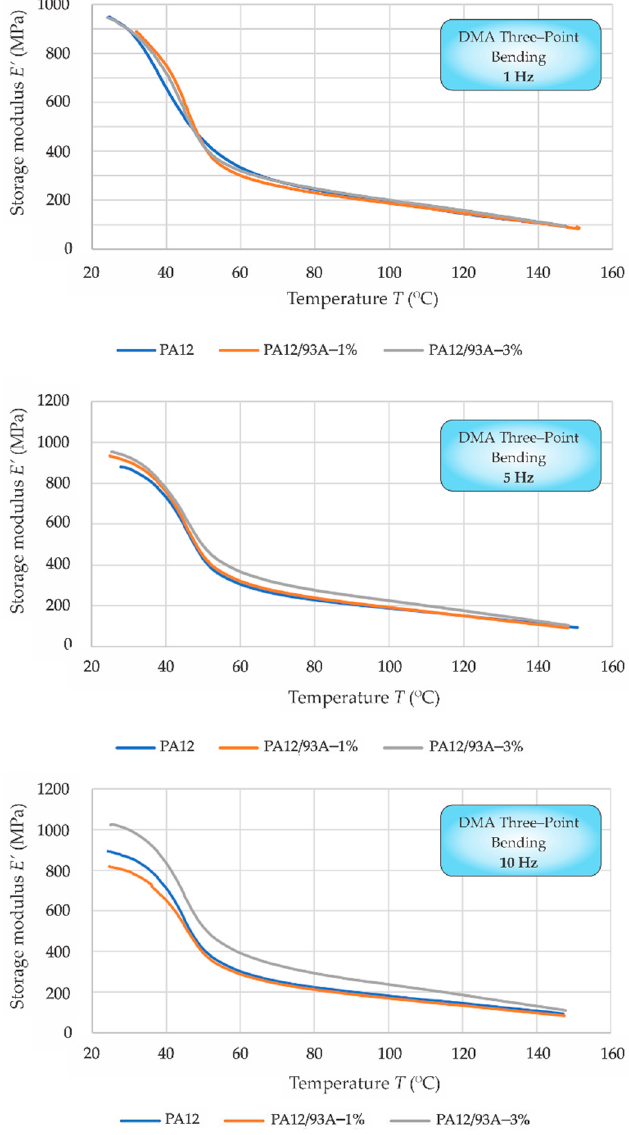
Figure 7. DMA three-point bending: storage modulus ( E’ ) versus temperature ( T ) at 1 Hz ( top ), 5 Hz ( middle ) and 10 Hz ( bottom ).